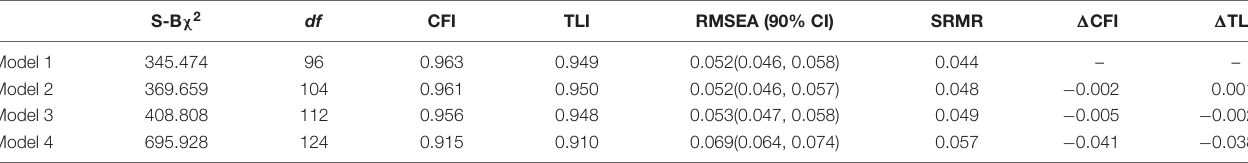
TABLE 4 | Testing for gender invariance.